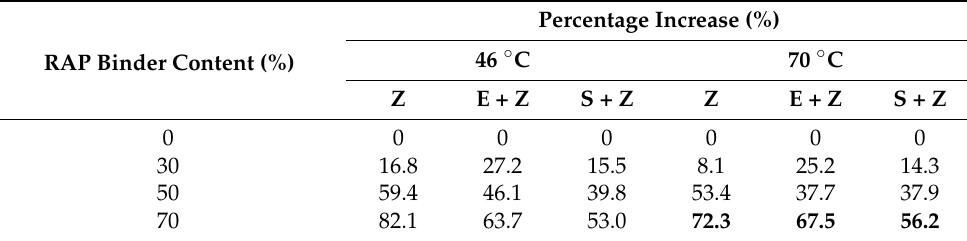
Table 5. Percentage increase in | G *|/sin δ with the RAP binder content under the unaged condition.